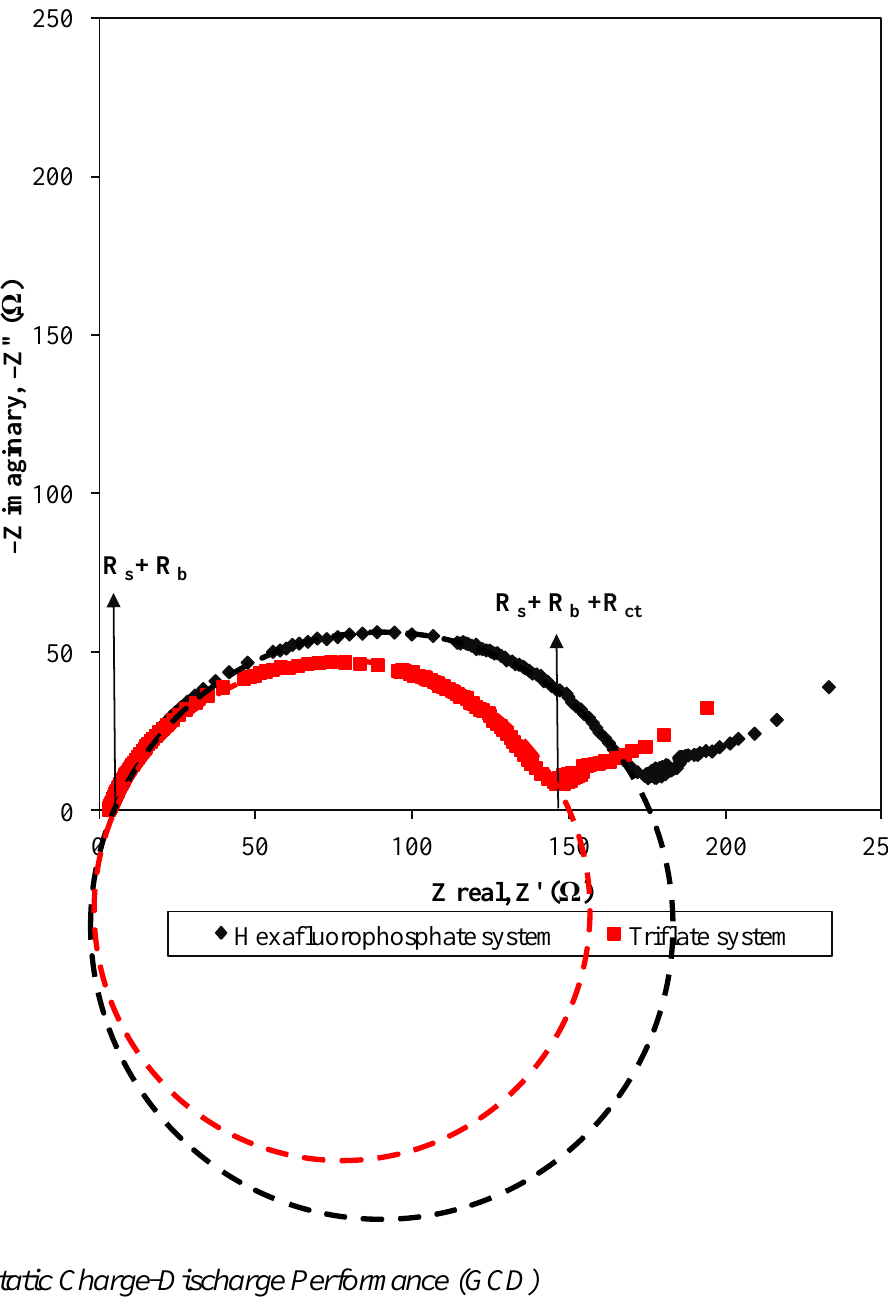
Figure 7 represents the galvanostatic charge-discharge curves of two different